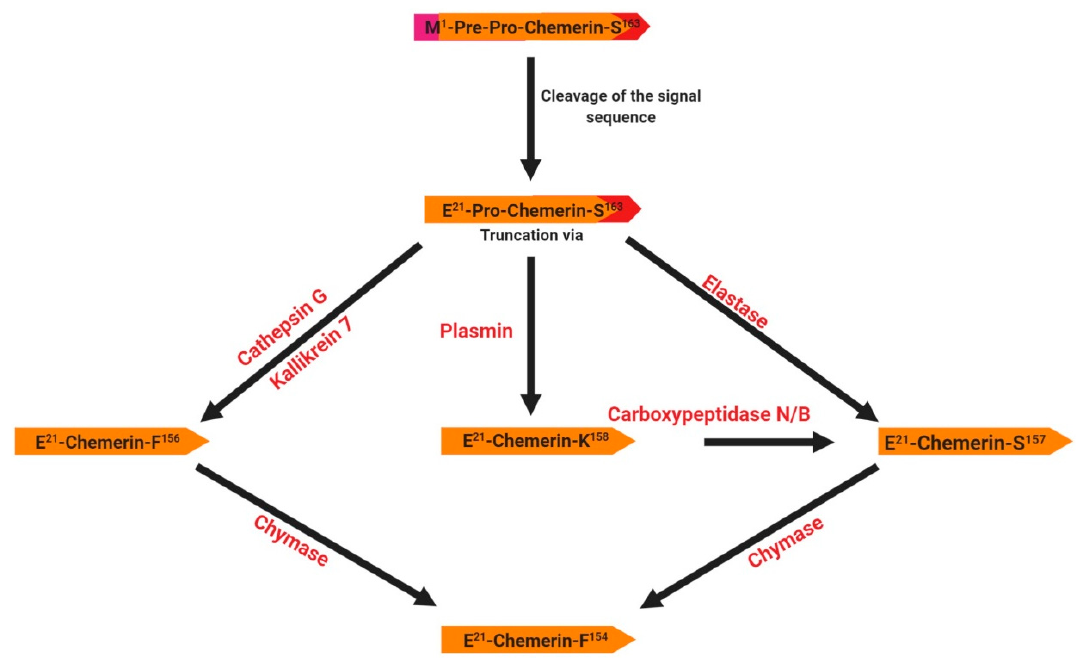
Figure 1. Structure and specific forms of human chemerin. The initial preprochemerin and its different products are processed by different proteases related to inflammation. The signal peptide (purple) is cleaved prior to secretion. Then, the C-terminus is cleaved by different proteases giving several active isoforms such as chemerin F 156 , chemerin S 157 and chemerin K 158 .